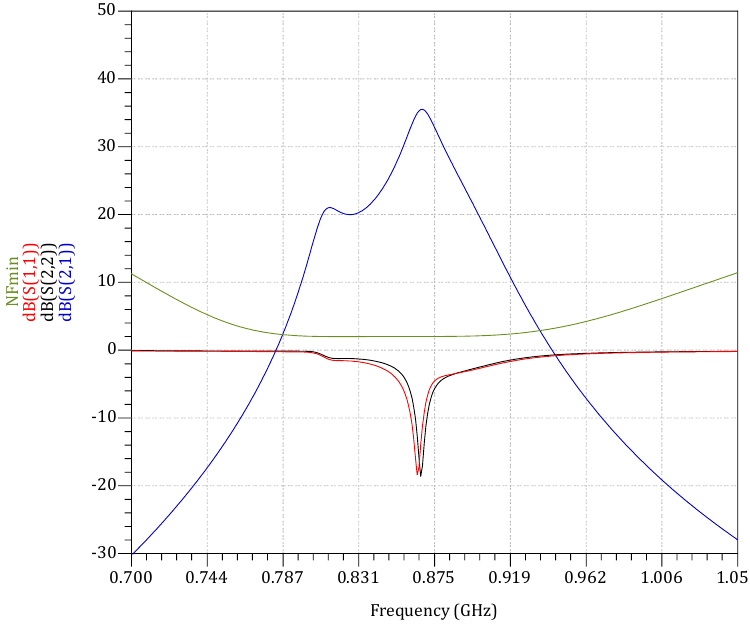
Figure 6. S-parameters and noise figure simulation of the two-stage LNA.